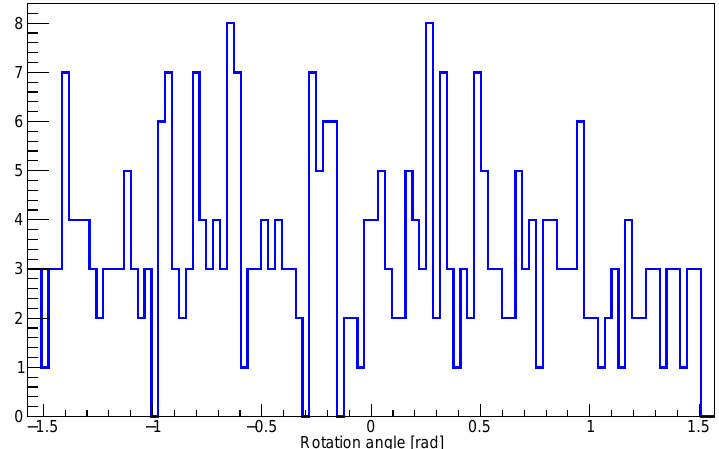
Figure 9. The distribution of the orientation of CRE signatures at the top of the atmosphere, for the primary photon energy 100 EeV, based on 324 CRE signatures. Histograms are normalised and divided into 100